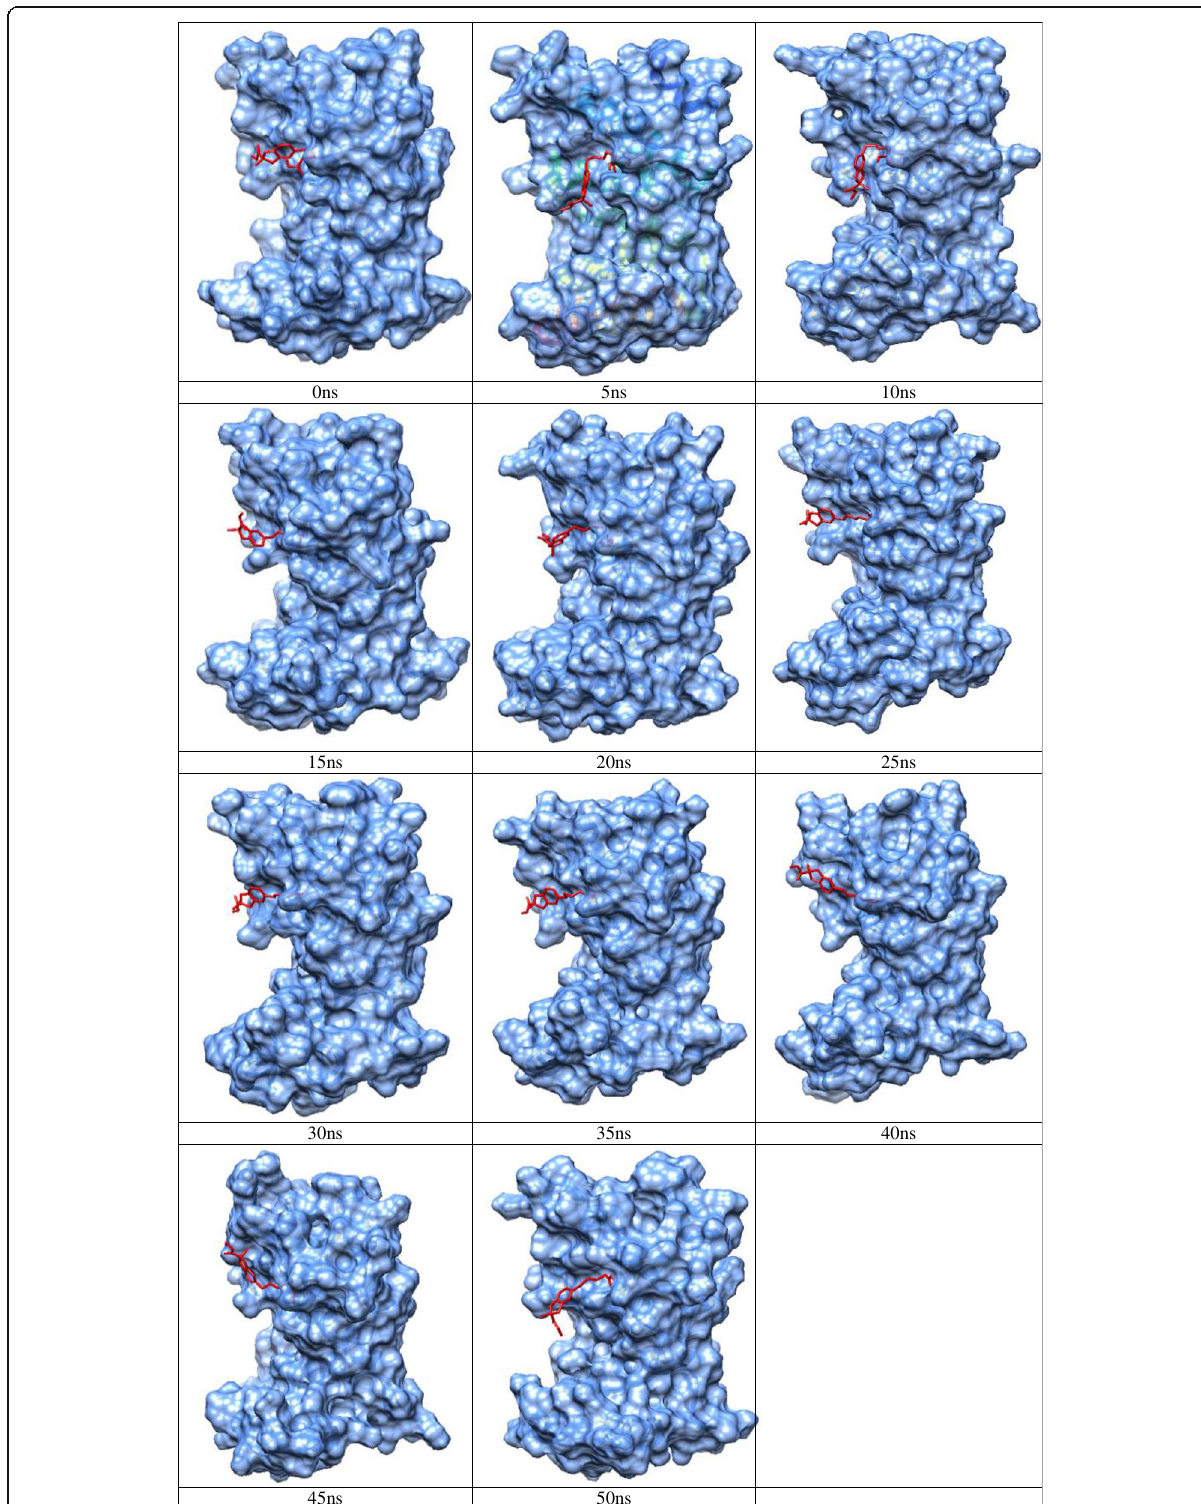
Fig. 5 5ns snapshot of DHB2+3dra